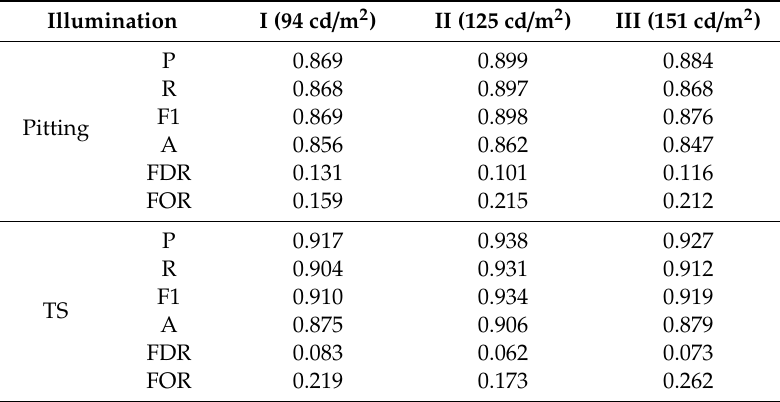
Table 4. Detection results under di ff erent illumination conditions.